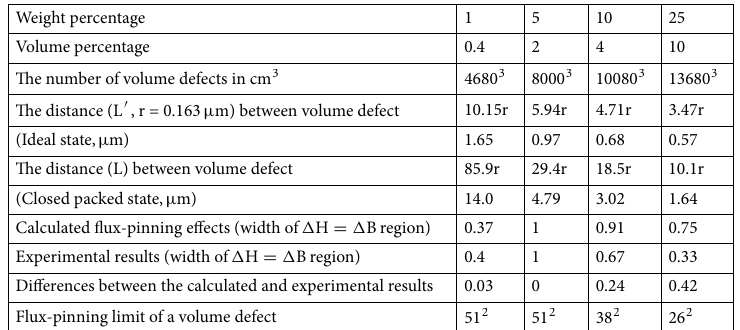
Table 1. Various properties of (Fe, Ti) doped MgB 2 superconductors according to weight percentage of (Fe, Ti) particles, of which average radius is 163 nm. L ′ and L are the distance between defects in ideal state and closed packed state, respectively. Closed packed state of volume defects is the state that all of fluxes penetrated m cps = 1, where m cps is the number of volume defects in close packed state 7 . are pinned at volume defects ( 2 r × (cid:31) B region of specimens are compared with that of 5 wt.% (Fe, Ti) doped MgB Widths of (cid:31) H = a